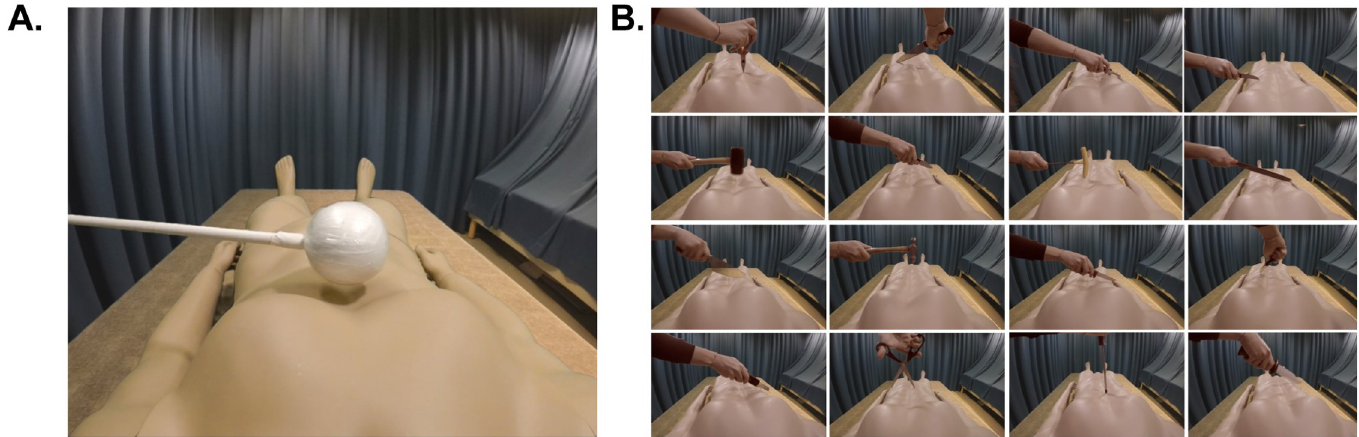
Fig 1. Visual material for the questionnaire and the SCR experiments. ( A ). The participant lay on a bed with his or her head tilted forward, wearing a head–mounted display (HMD). In the HMD, the participants saw a mannequin lying on a bed from a first–person perspective, and they were exposed to temporally synchronous or asynchronous visuo–tactile stimulation (0.5 Hz) using a white styrofoam ball attached to a wooden stick. At the same time, the visual background made a brief rotation movement (oscillated 3˚/sec) around the mannequin once every six seconds to induce an illusory clockwise motion sensation in the roll plane in the participants. These visual oscillations were presented synchronously or asynchronously with the electrical stimulation of the vestibular nerve (GVS), which elicited a brief sensation of clockwise rotation in the roll plane and translation to the left. ( B ). Sixteen different physical threat stimuli were used to register the participants’ threat–evoked skin conductance